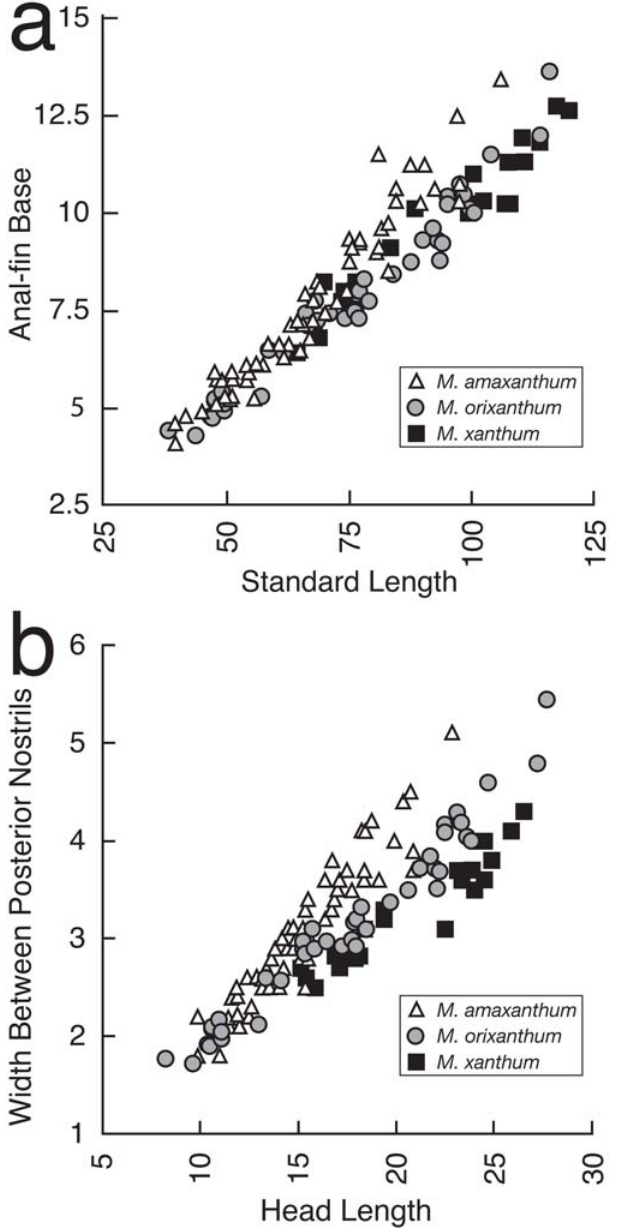
Fig. 5. Scatter plots illustrating: a , anal-fin base length relative to standard length, and b , width between posterior nostrils relative to head length, in Megalonema xanthum (squares, n=23), M . amaxanthum (triangles, anal-fin base n=71, width between posterior nostrils n=70), and M . orixanthum (circles, n=41). In t-tests of the residuals from regression, M . amaxanthum proved to have a significantly longer anal-fin base length than M . orixanthum and M . xanthum (p-values <0.0001 for pairwise comparisons), and all three species are significantly different from each other in width between posterior nostrils with increasing relative widths from M . xanthum , M . amaxanthum to M . orixanthum (p-values for pairwise comparisons